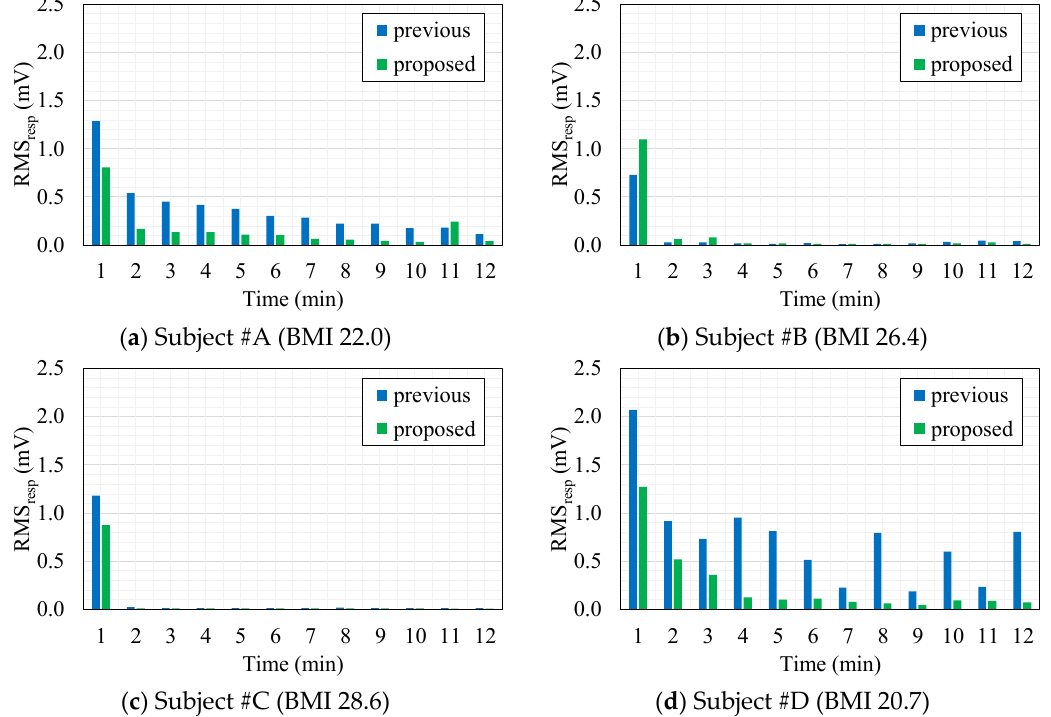
Figure 8. Minute-by-minute transitions of the root mean square voltage (RMSV resp) extracted from cECG recordings measured with the previous AFE (blue) or the proposed AFE (green) in each subject. ( a ) Subject #A (BMI 22.0). ( b ) Subject #B (BMI 26.4). ( c ) Subject #C (BMI 28.6). ( d ) Subject #D (BMI 20.7).